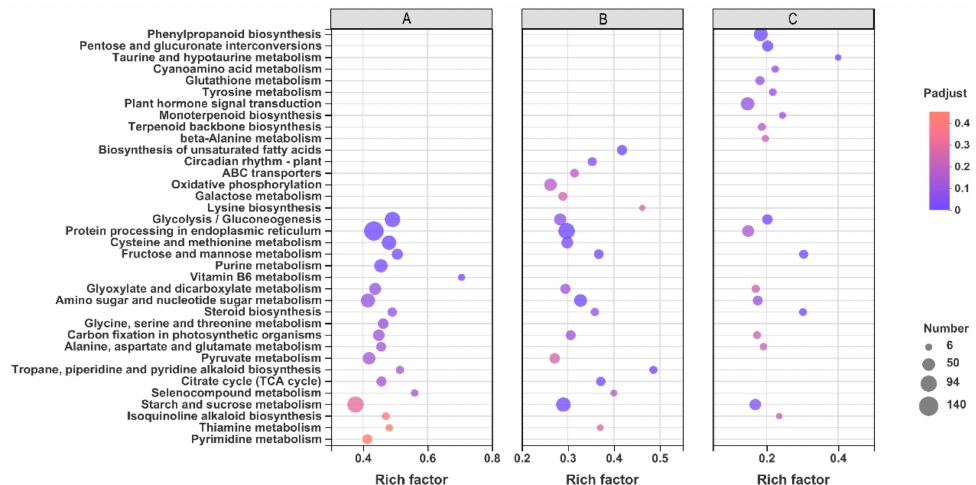
Figure 7. Kyoto Encyclopedia of Genes and Genomes (KEGG) pathway enrichment analysis of DEGs among CK, HYD, and HEHP. ( A ) The top 20 enriched KEGG pathways of the DEGs identified in CK vs. HEHP; ( B ) The top 20 enriched KEGG pathways of the DEGs identified in CK vs. HYD; ( C ) The top 20 enriched KEGG pathways of the DEGs identified in HYD vs.